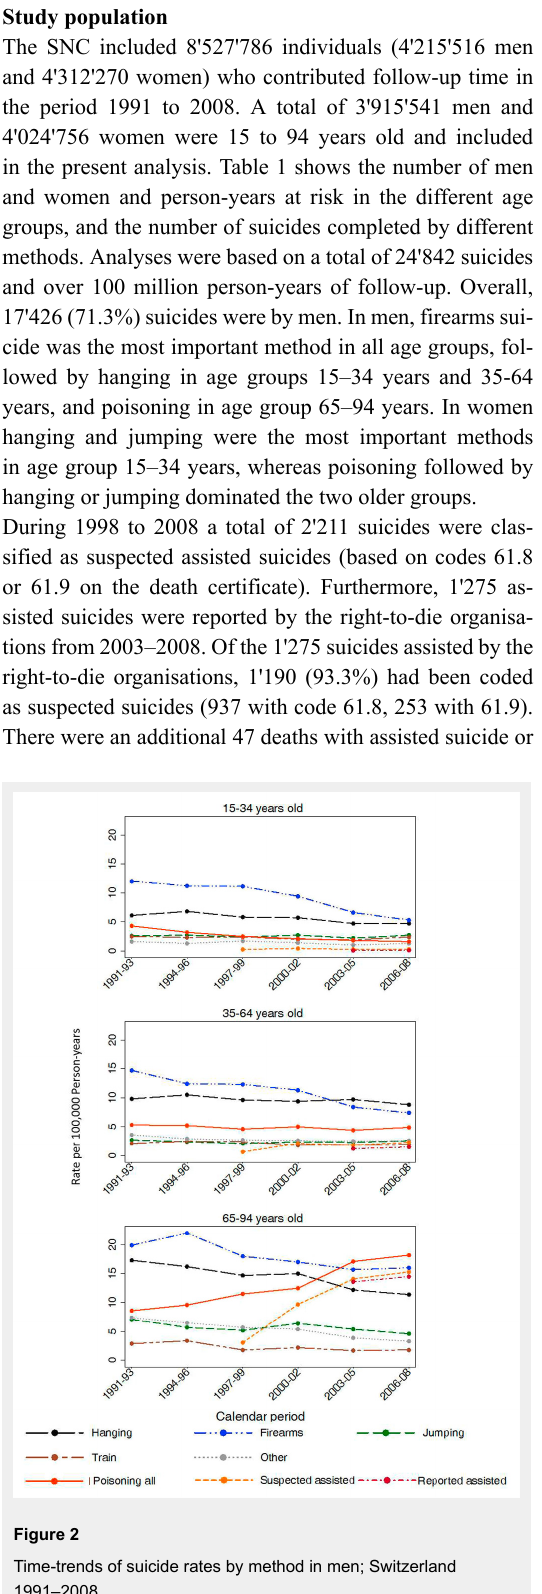
Time-trends of suicide rates by method in men; Switzerland